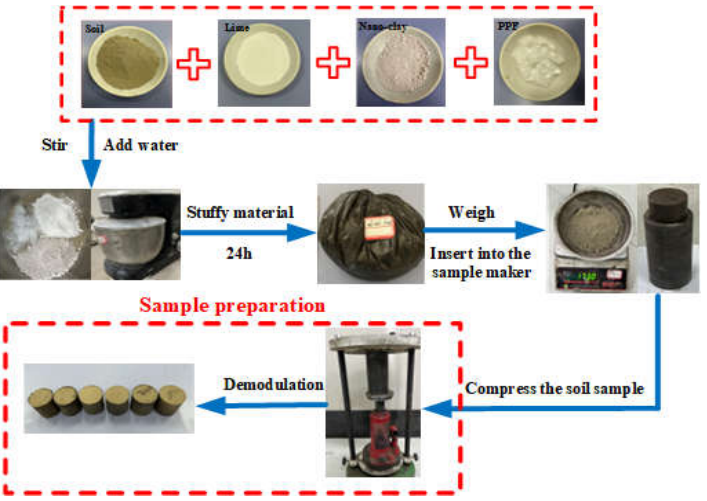
Figure 1. Sample preparation process.